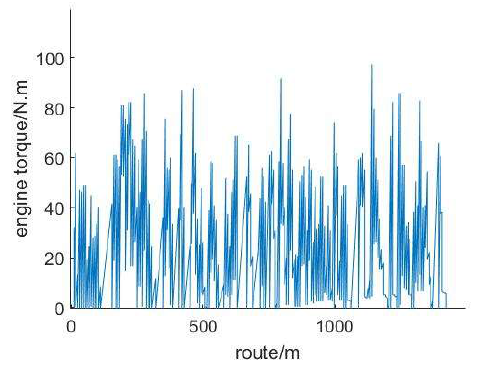
Figure 18. Fuzzy control engine torque.